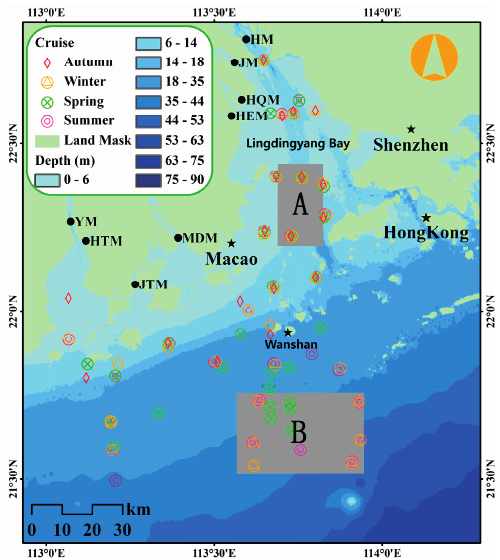
Figure 1. Schematic map of the Pearl River Estuary. Eight runoff outlets of the Pearl River are symbolized by black dots ( ● ) and labeled as HM (HuMen), JM (JiaoMen), HQM (HongQiMen), HEM (HEngMen), MDM (MoDaoMen), JTM (JiTiMen), HTM (HuTiaoMen), YM (YaMen). The bathymetric chart was interpolated from water depth points of nautical charts in 2008, at the scale of 1:50,000. Region A and B were defined to discuss variations of annual mean POC concentration from 2002 to 2014, as discussed in Section